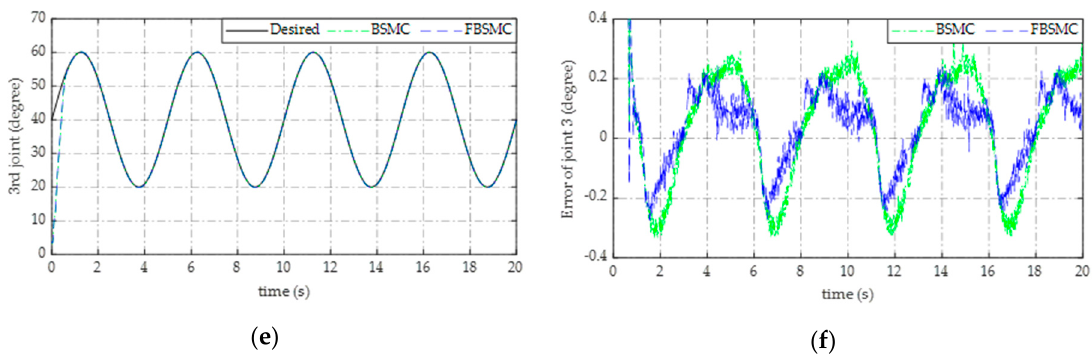
Figure 22. The tracking performance of the three joints in case of sinusoidal signal without load: ( a ) The first joint and ( b ) its error; ( c ) the second joint and ( d ) its error; ( e ) the third joint and ( f ) its error in comparison between SMC and FSMC.